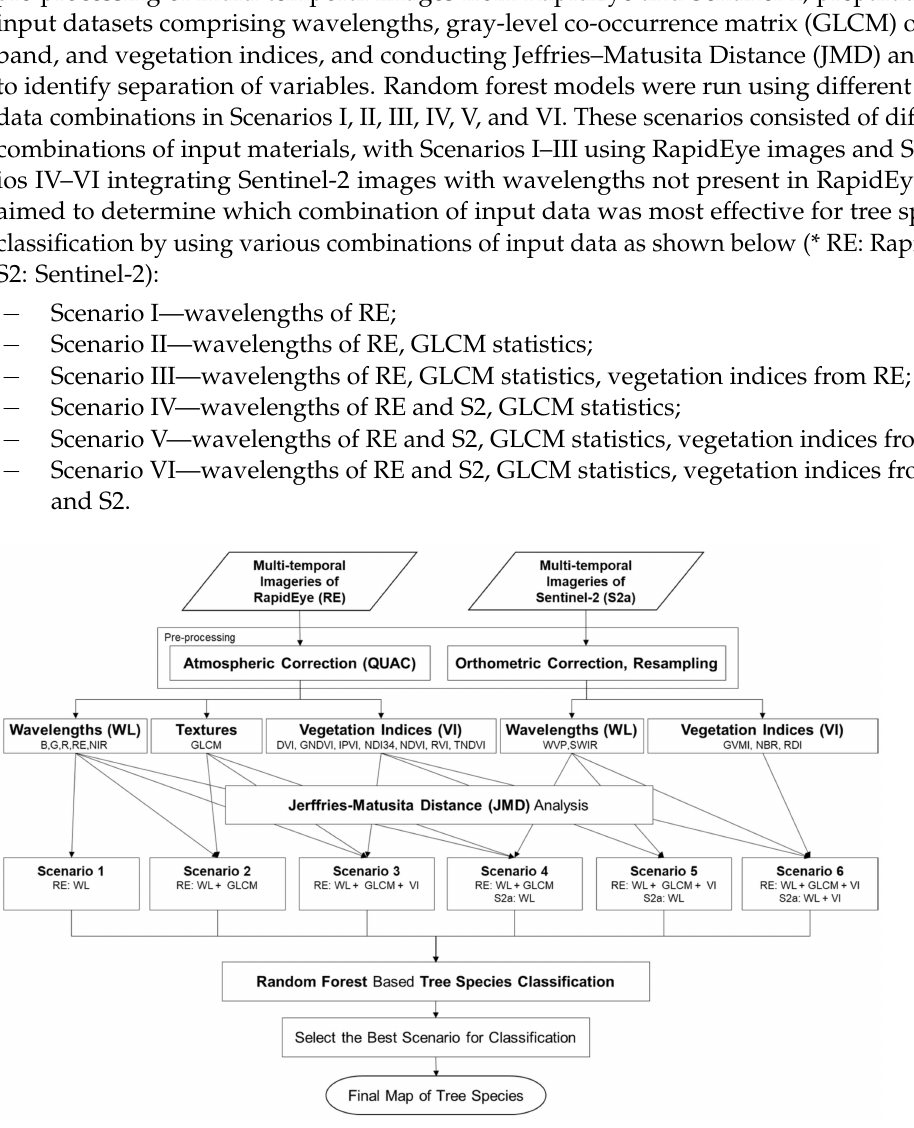
Figure 1. Research flow for the